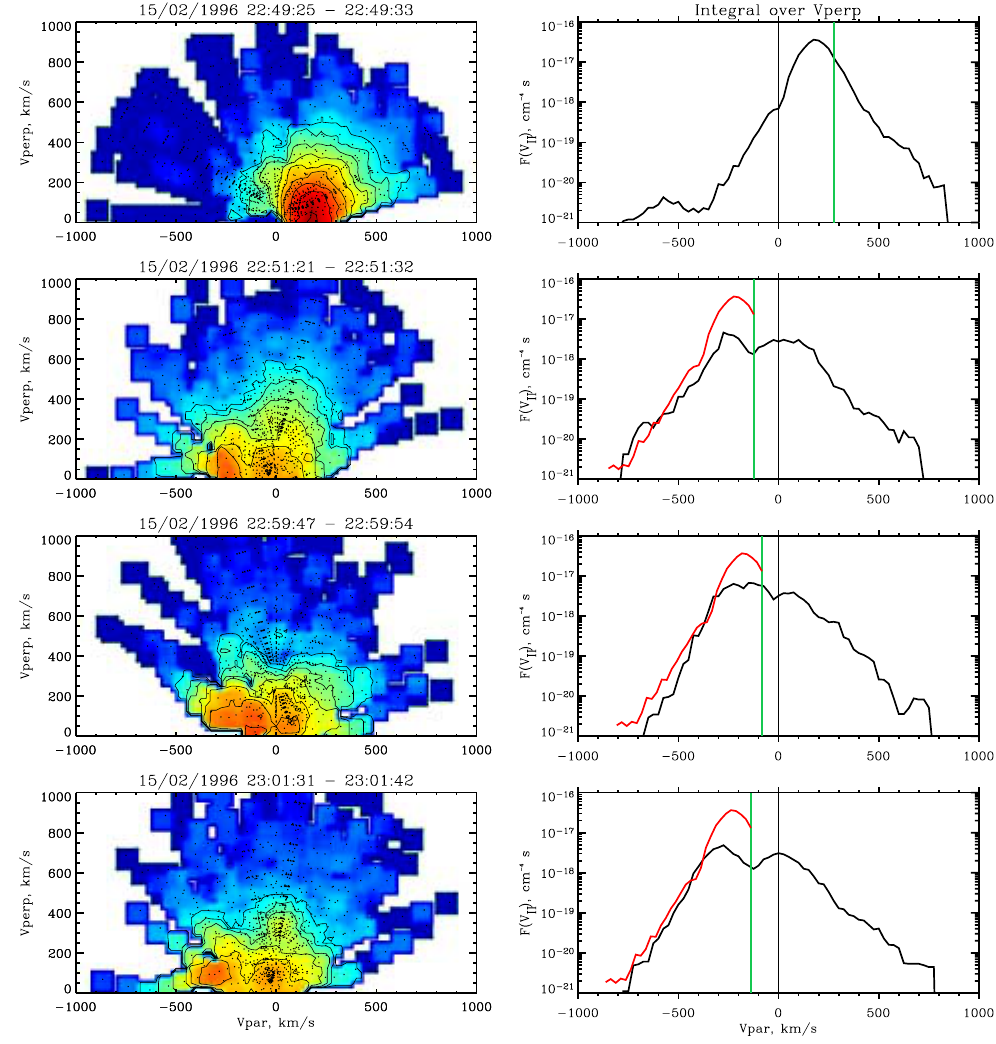
Fig. 10. Magnetosheath velocity distribution observed before magnetopause crossing on 15 February 1996 (top) and three LLBL velocity distributions with a high-density, high-speed ion component along negative magnetic field direction observed within LLBL intervals 3 and 5 in Fig. 2. V k − V ⊥ velocities space cuts are on the left, V k -velocity distributions are on the right. The deHoffman-Teller frame velocity cut is shown by a vertical green line on magnetosheath V k -velocity distribution. Red lines at each V k -velocity distribution in the LLBL show the magnetosheath plasma velocity distributions that should enter magnetospheric field lines if they are reconnected to magnetosheath field lines. The velocity cut location on the V k -coordinate was determined as a projection of dHT velocity on the local magnetic field direction for each